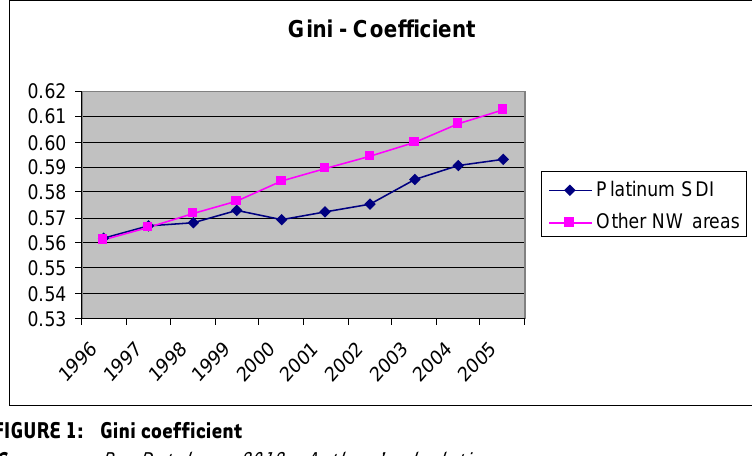
FIGURE 1: Gini coefficient Source: Rex Database, 2012 – Authors’ calculations The Pearson coefficient of 0.941 indicated a very close correlation and no significant